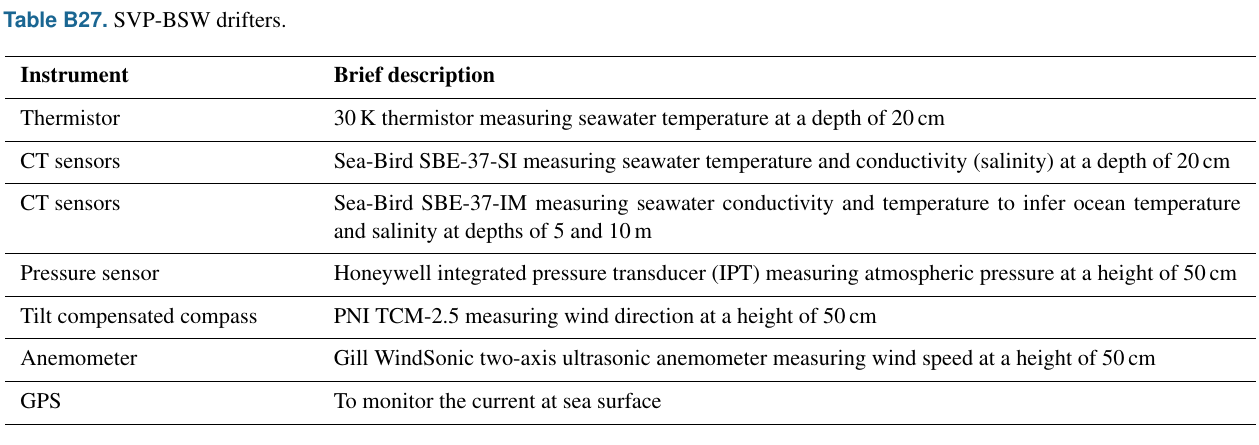
Table B27. SVP-BSW drifters.